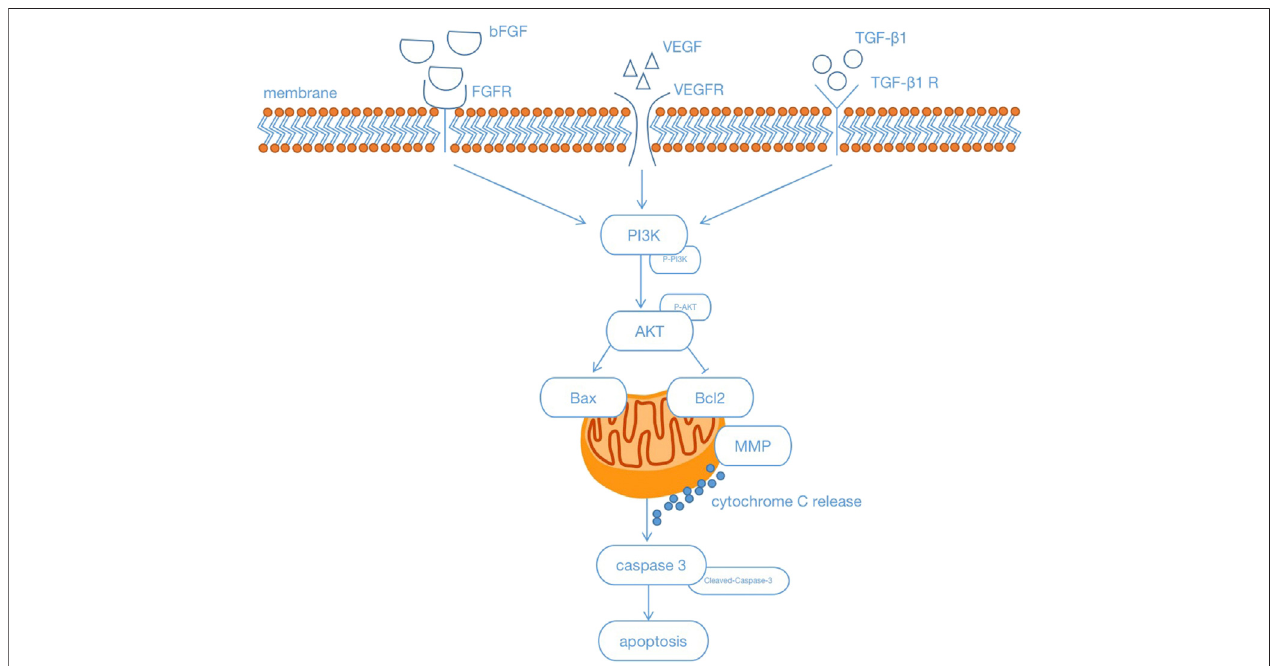
FIGURE 16 | Schematic illustration showing that Guhong injection protected antiapoptosis and the integrity of the cerebral microvasculature and mitochondria through the PI3K/Akt signaling pathways under cerebral